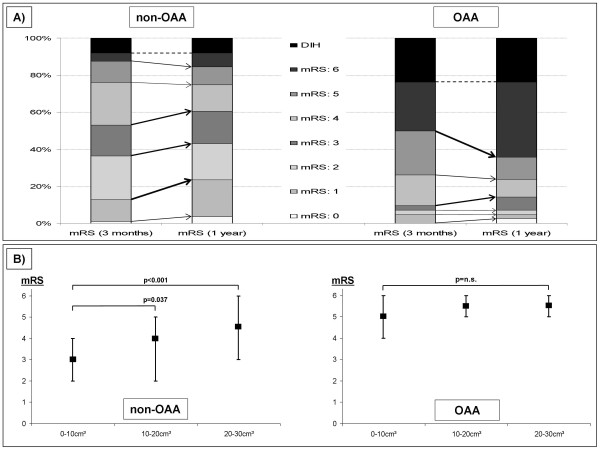
(A) Dichotomized analysis of the mRS distribution at 90 days and 1 year for non-OAA and OAA patients with minor-volume ICH. The dashed line indicates, within the mRS = 6 group, the proportion of patients who already died in the hospital (DIH). The thickness of arrows indicates the proportional shift from short- to long-term outcome within the mRS groups (B) Association of hematoma volume and outcome in non-OAA patients and OAA patients. Note, that there is a clear association of hematoma volume and outcome only in non-OAA patients.